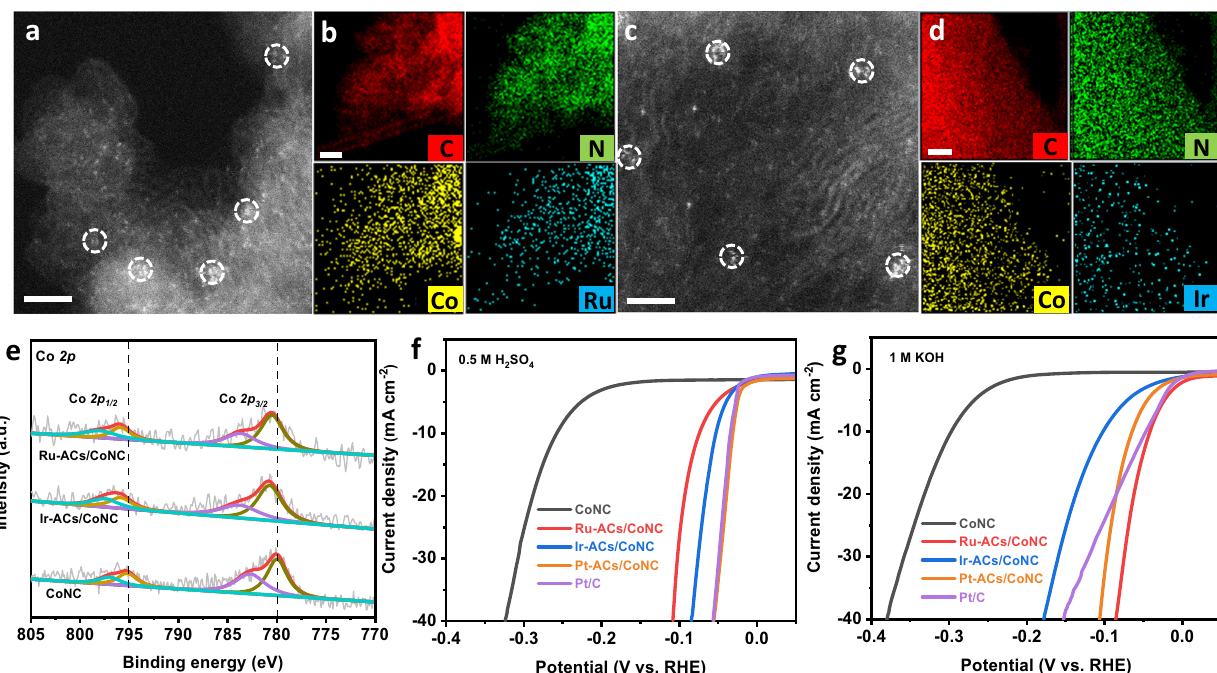
Fig. 5 Characterization and HER performance of Ru-ACs/CoNC and Ir-ACs/CoNC. a , b STEM image and elemental mapping of Ru-ACs/CoNC. Scale bar: 2 and 50 nm. c , d STEM image and elemental mapping of Ir-ACs/CoNC. Scale bar: 2 and 50 nm. e The high-resolution XPS spectra of Co 2p in CoNC, Ru-ACs/CoNC and Ir-ACs/CoNC. f , g HER polarization curves of CoNC, Ru-ACs/CoNC, Ir-ACs/CoNC, Pt-ACs/CoNC and Pt/C in 0.5 M H 2 SO 4 and 1 M KOH,